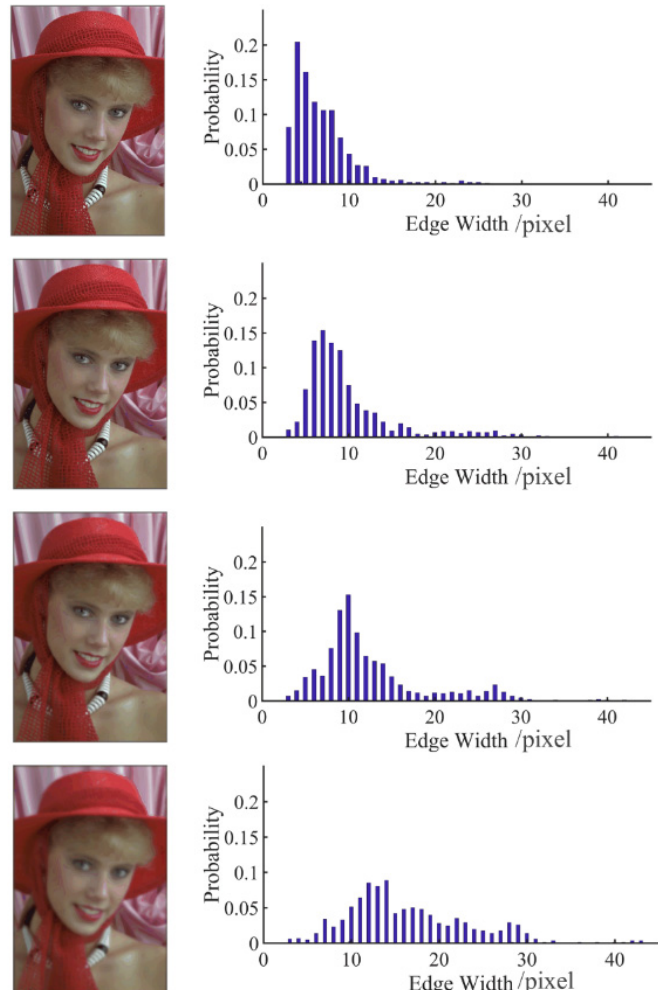
Figure 11. Histogram of edge width under different blurring degrees of “womanhat”.